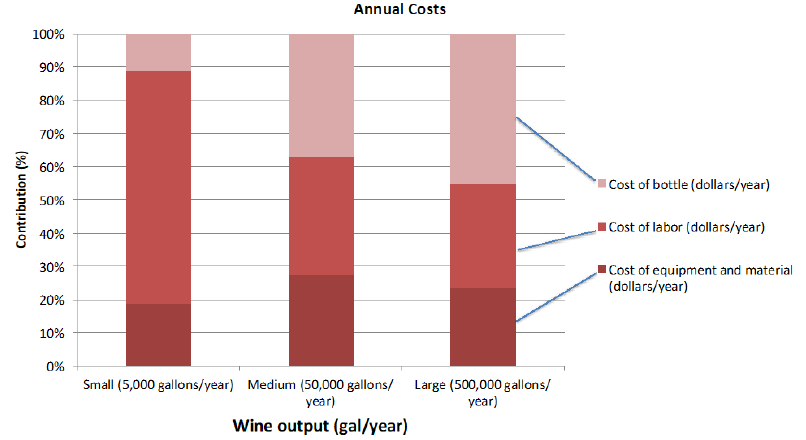
Figure 6. Allocation of annual production costs, according to type of cost and production scale. Note that many costs are impacted by economies of scale.